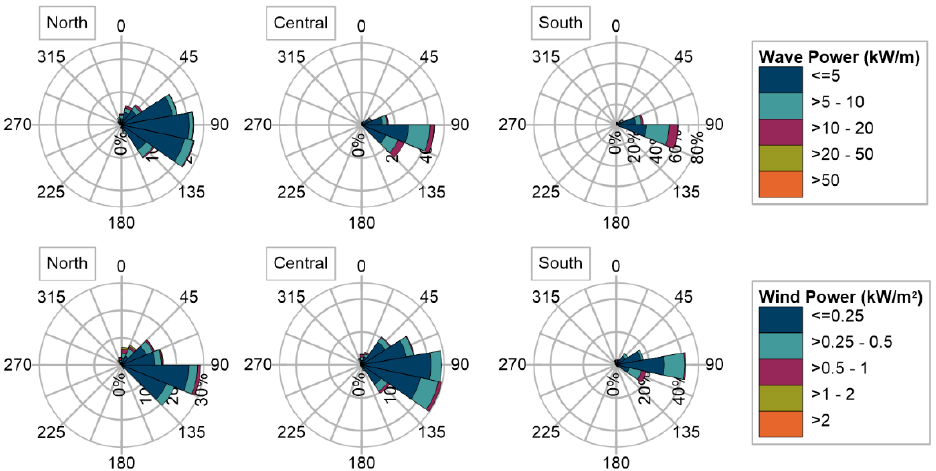
Figure 3. Prevalent wave ( top ) and wind ( bottom ) power charts for January 1979–December 2019 for three points along the Mexican Caribbean coast. Data obtained from Era5 climate reanalysis [22] .